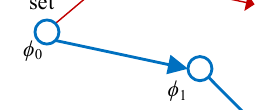
Figure 2. Update gradient by gradient.